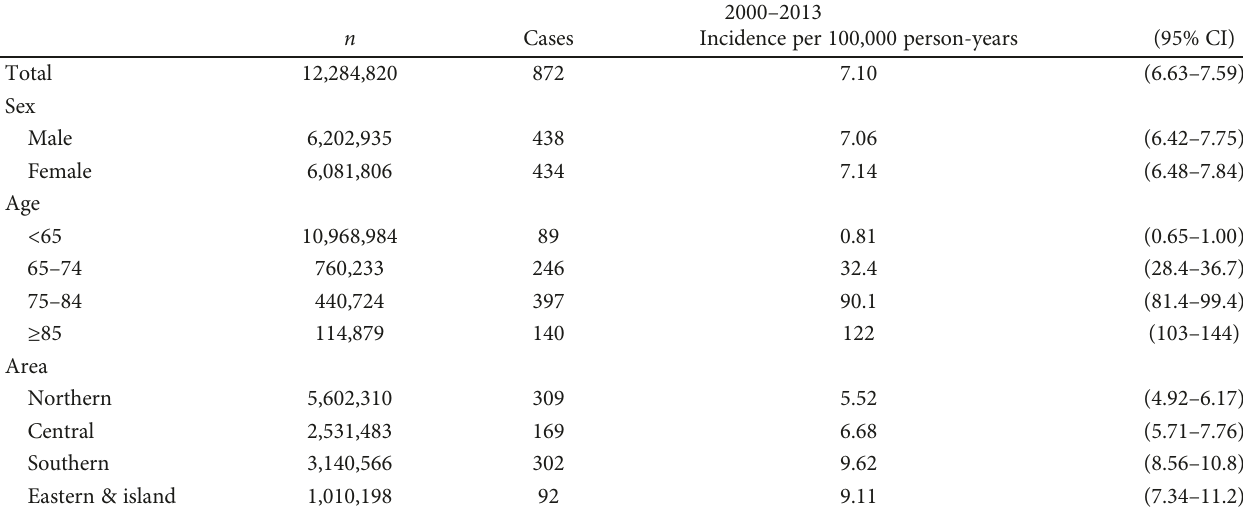
Table 2: Incidence rate of